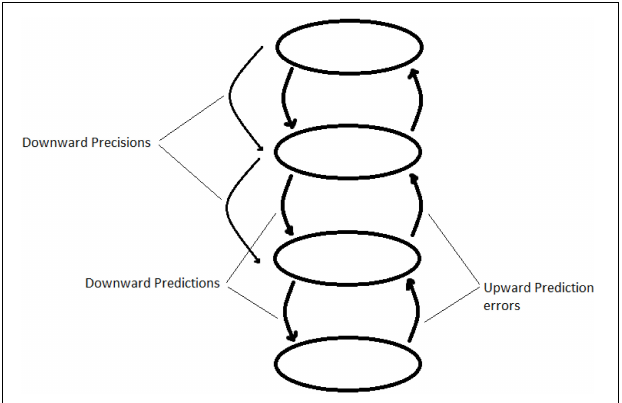
FIGURE 6 | A hierarchical generative model which passes prediction error up the hierarchy while passing predictions (and precisions)